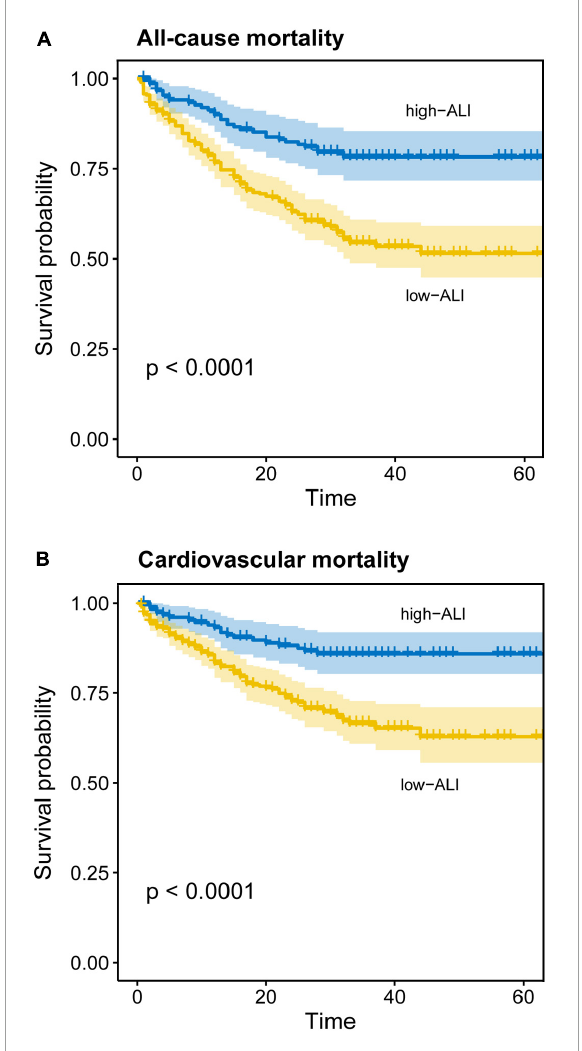
FIGURE3 Kaplan–Meier curves for all-cause and cardiovascular mortality in elderly patients with heart failure. Cumulative event-free rate according to ALI on admission for (A) all-cause mortality and (B) cardiovascular